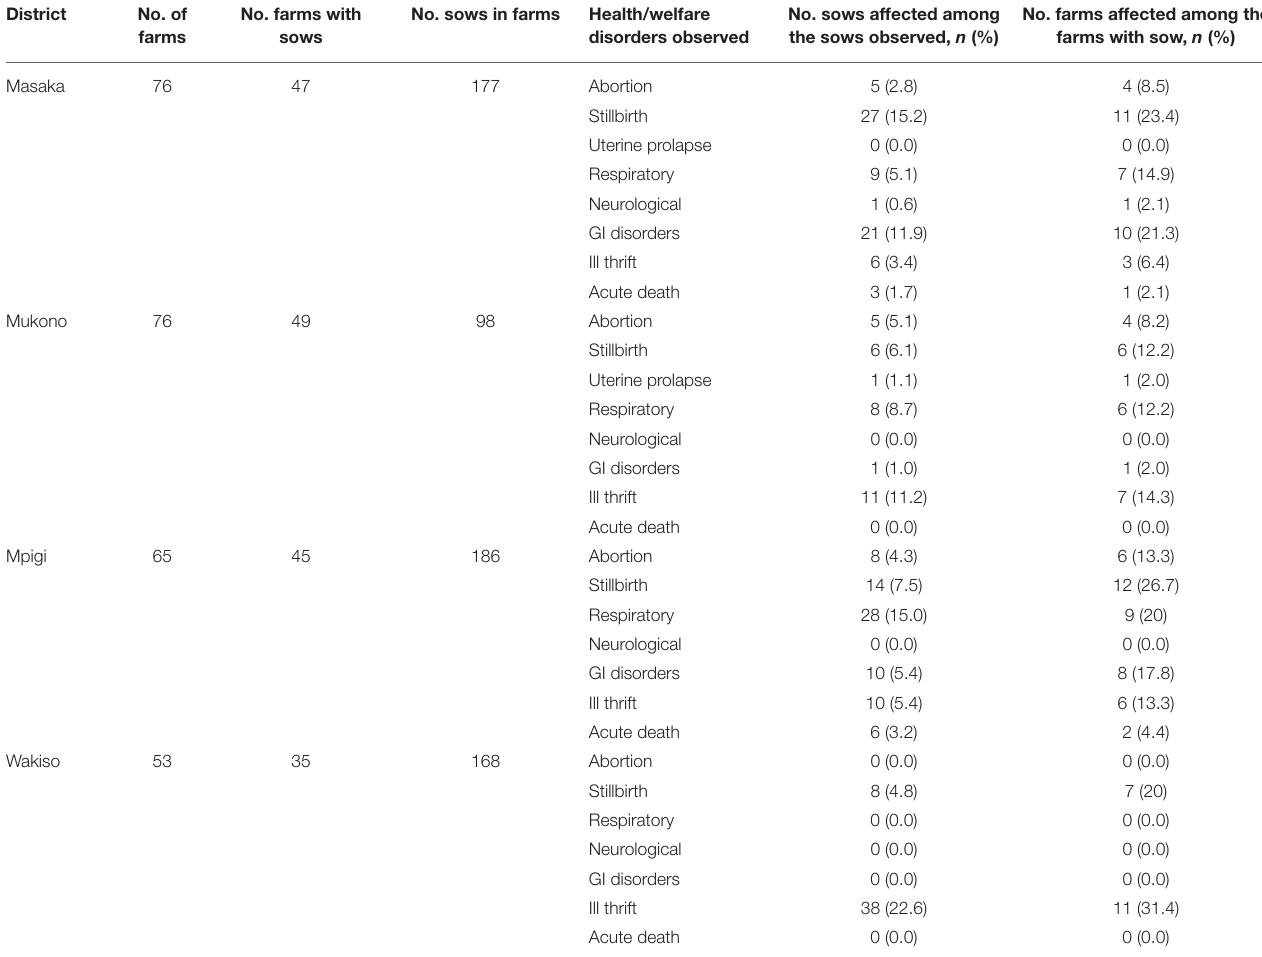
TABLE 6 | Health/welfare conditions in sows reported by farmers during the last 12 months. District No. of